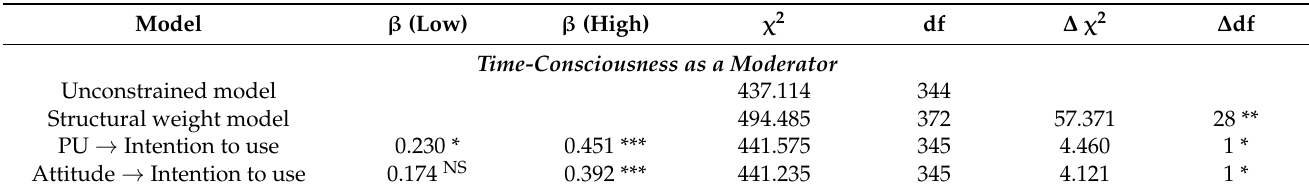
Table 6. Multi-group test